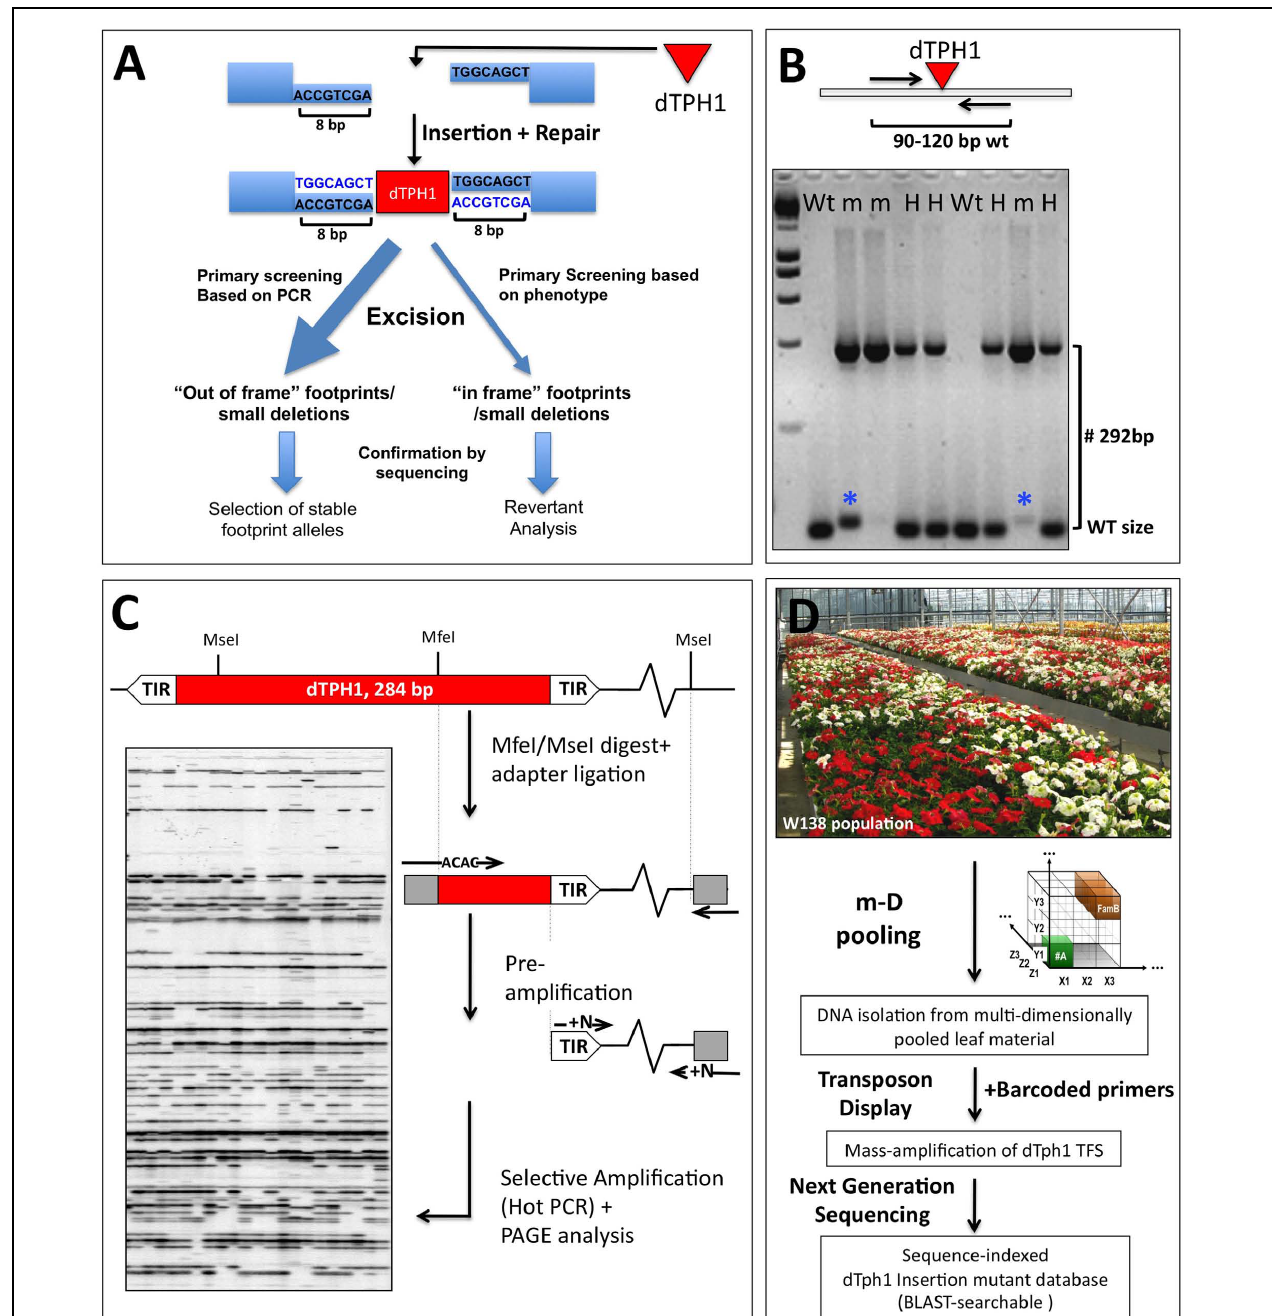
FIGURE 2 | Petunia dTPH1 transposon biology and mutagenesis. (A) Petunia dTPH1 creates a 8 bp target site duplication upon insertion. Excision of the dTPH1 transposon from an insertion site and subsequent repair may have a variable outcome, resulting in different classes of excision alleles (van Houwelingen et al., 1999). For insertions in the coding sequence, excision will result in an out of frame mutation in most cases, while more rarely, this may result in restoration of gene function (revertant), in case the remaining footprint/deletion is a multiple of three. Note that revertant analysis can be used as a strategy to provide independent proof of gene function. (B) The small size of the dTPH1 transposon allows easy genotyping in a single PCR reaction. A 4% agarose gel is shown loaded with PCR products resulting from amplification with a gene-specific primer pair flanking the insertion site. Fragments containing the dTPH1 element are 292 bp larger than the WT fragment (284 bp of the transposon + 8 bp target site duplication). Genotypes are indicated Wt = homozygous wild-type; H = heterozygous; m = homozygous mutant. The blue asterisks indicate partial excision of the transposon, resulting in a fragment slightly larger than WT. (C) dTPH1 Transposon Display procedure, used in the forward cloning of dTPH1 tagged mutants in petunia forward genetics. See Van den Broeck et al. (1998) and Vandenbussche et al. (2013) for more details. (D) Procedure for the massive parallel amplification and sequencing of dTPH1 flanking sequences, derived from populations of 1000–4000 individuals. The resulting sequence database can be BLAST-searched for reverse genetics purposes. For experimental details, see Vandenbussche et al. (2008).